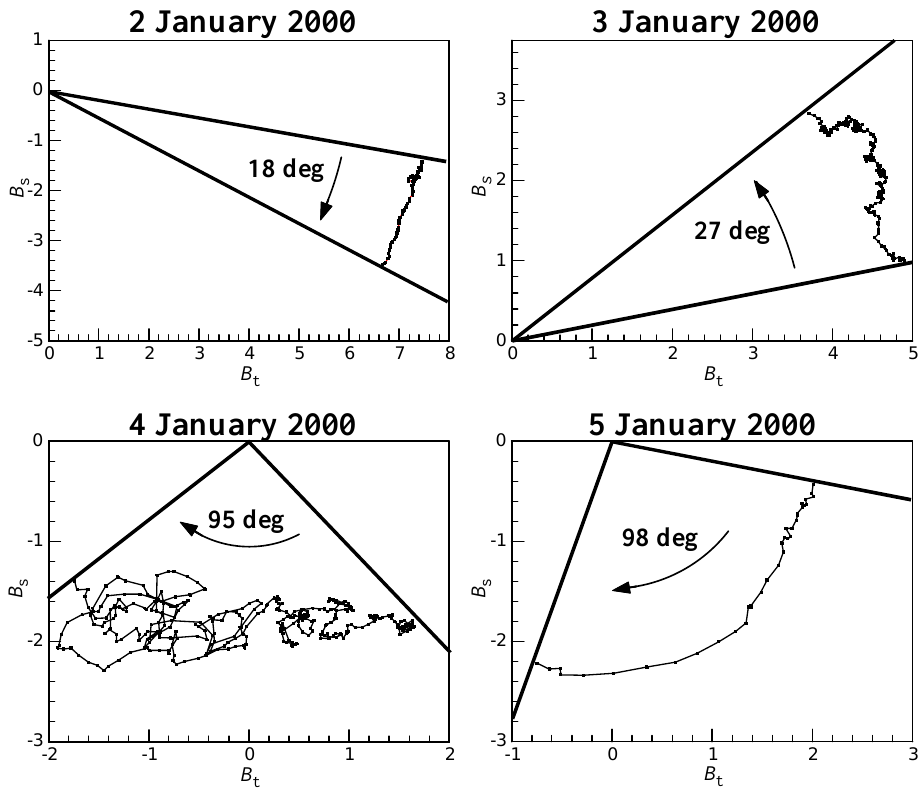
Fig. 14. Through the R-layer of each double discontinuity observed on 2–5 January 2000, the magnetic field rotates by a large angle about Figure 14 the normal direction of the shock surface, while its magnitude remains nearly constant. The rotation angles of the four double discontinuities are 18 ◦ , 27 ◦ , 95 ◦ , and 98 ◦ ,